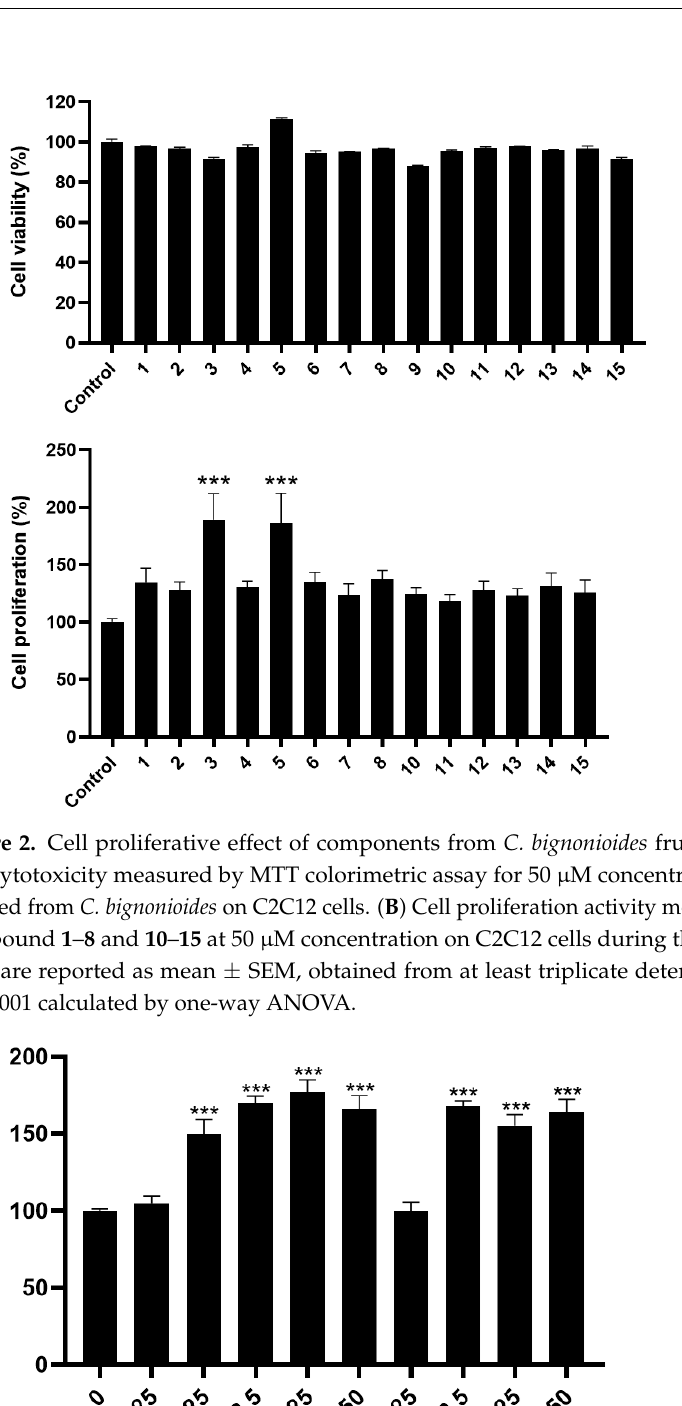
Figure 3. Pinoresinol and vanillic acid facilitating proliferation of mouse myoblasts in a dose-de- pendent manner. Cell proliferation activity measured by BrdU assay of pinoresinol and vanillic acid at various concentrations on C2C12 cells during the differentiation period. Data represent the mean